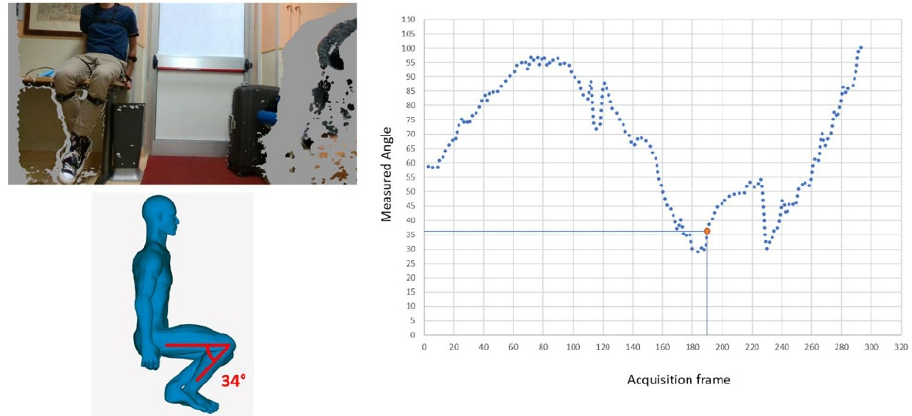
Figure 13. Comparison between the CAD-based measurement on the 3D avatar (ground truth) and the automatic measurement in case of seated knee flection.